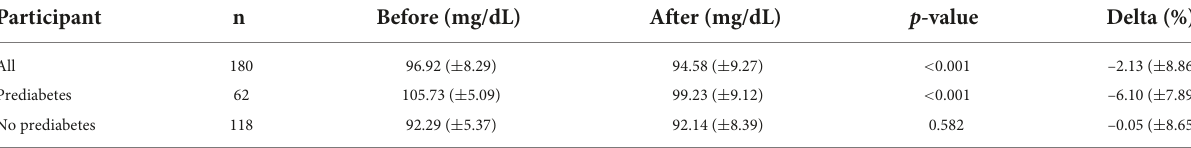
TABLE 2 Comparison of fasting glucose (mg/dL) before and after the